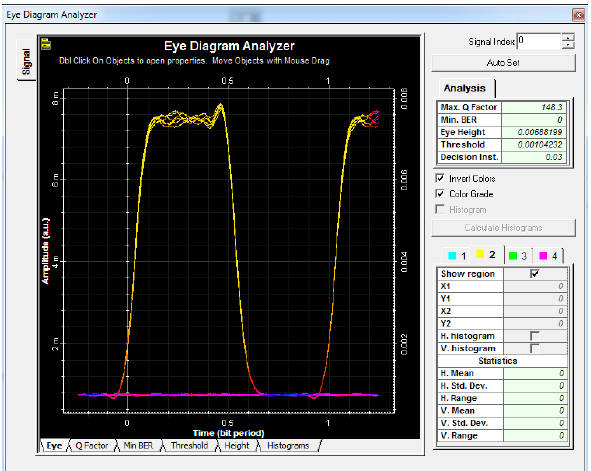
Figure 7: Results of the eye diagram analyzer with the directly modulated laser source along a cable length of 30 km.